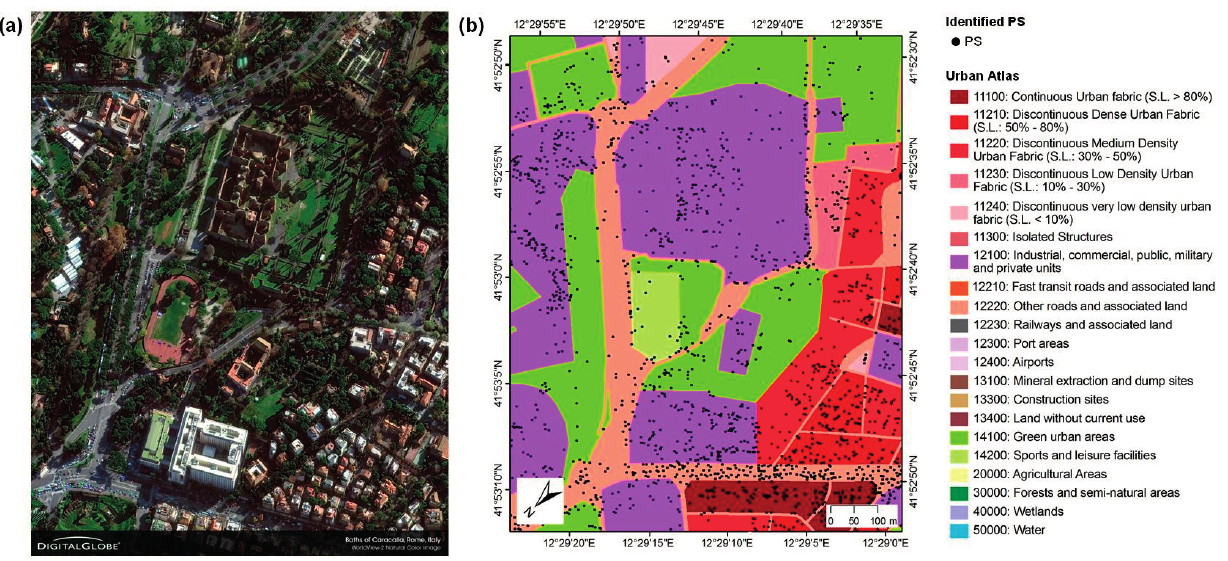
Figure 7. ( a ) VHR WorldView-2 image depicting the monumental ruins of the Baths of Caracalla (courtesy of Planetek Italia) and ( b ) land cover and distribution of the PS targets identified with